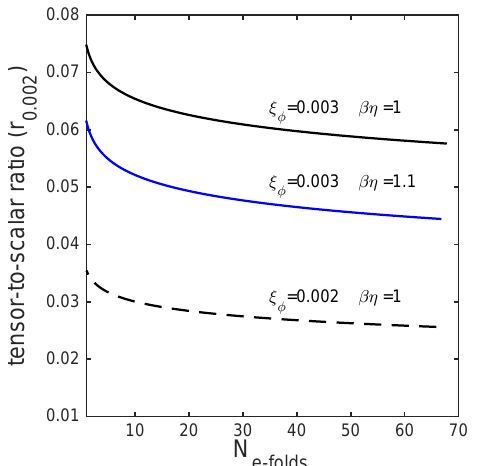
Figure 2. Evolution with the number of e-folds of the tensor-to-scalar ratio at the Hubble crossing scale k ∗ = 0.002 Mpc − 1 for two different values of the couplings ξ ϕ and ˜ α = βη / M 4 constants at t = 0 are: α = 1.5 × 10 − 9 , β = 1.5 × 10 − 13 , ξ h = 0. The underlying cosmological model is the Λ CDM model described by the following parameters: Ω b h 2 = 0.0226, Ω c h 2 = 0.112, H 0 = 70 km s − 1 Mpc − 1 , τ =